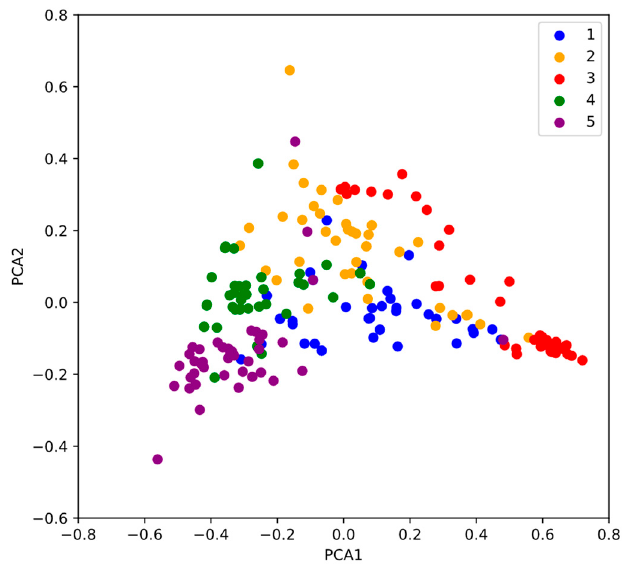
Figure 3. PCA of sample data (200 sets, in percent).